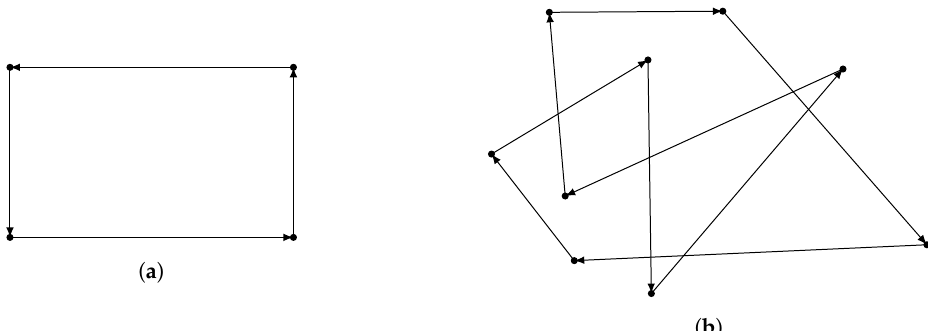
Figure 8. Sensor trajectory: ( a ) Rectangle trajectory. ( b ) Random point